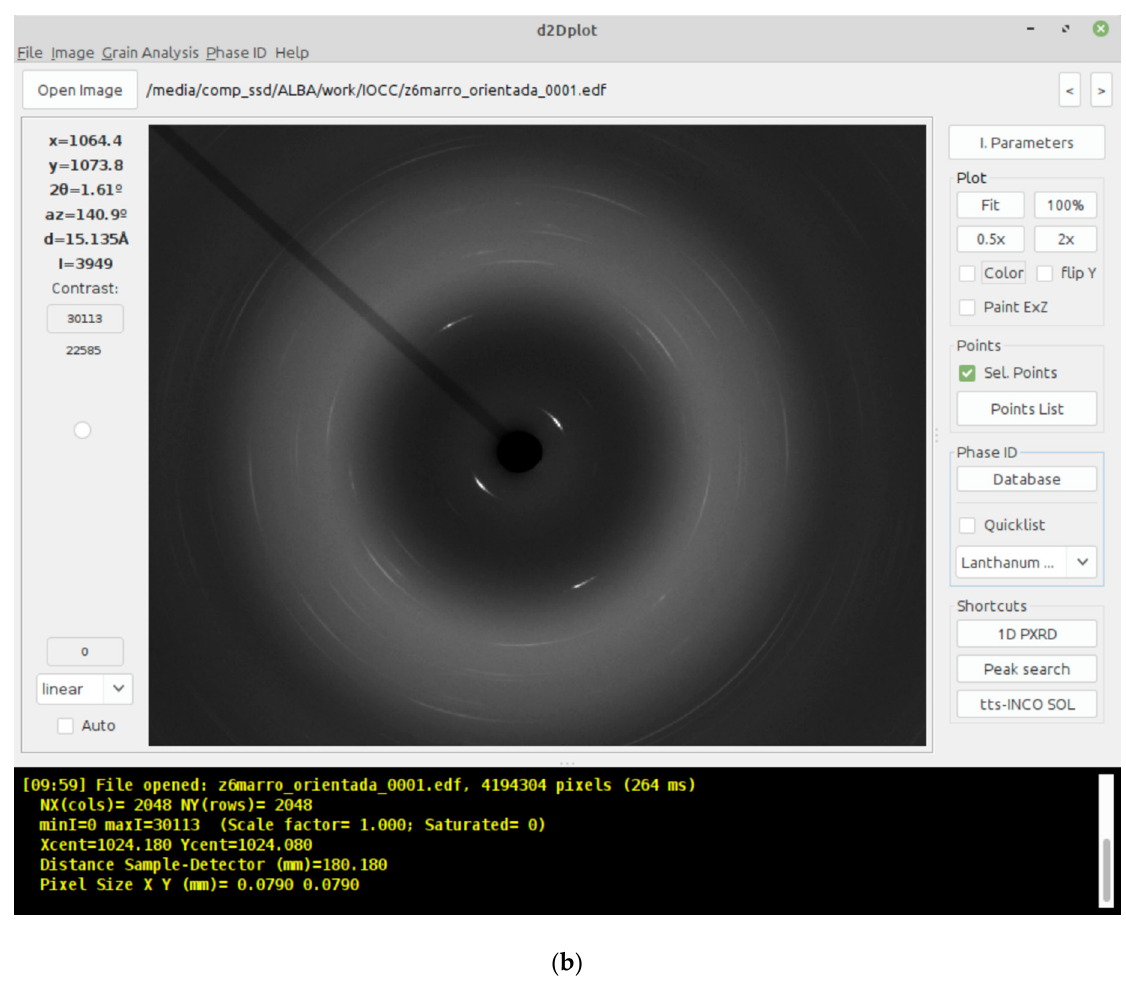
Figure 1. ( a ) Main windows of the programs: ( a ) d1Dplot showing the right panel with visualization options and the table with the list of opened data series, in this case a powder diffraction pattern and a peaks series; ( b ) d2Dplot showing an opened 2D XRD image with the on-screen cursor information on the left panel and the most used options on the right